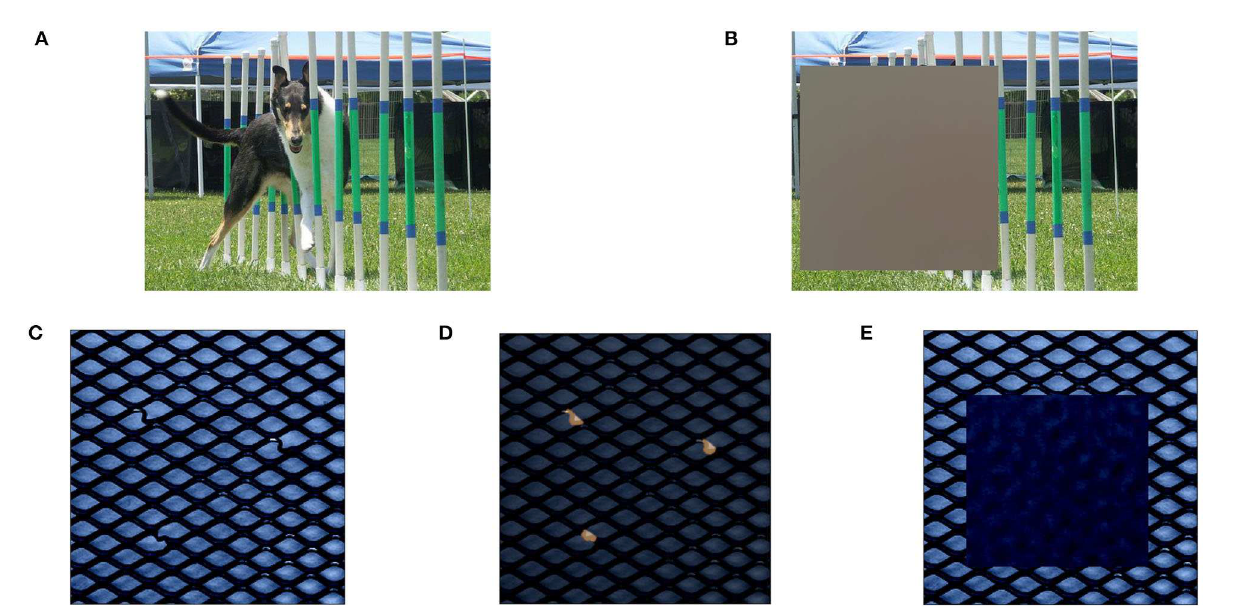
FIGURE2 Demonstration of perturbation with mean reference r in classification (A, B) and anomaly detection (C, E) . In classification, mean reference is capable of completely removing the class signal “dog” in image (B) . In anomaly detection, replacing all areas that contain anomalies [highlighted in image (D) ] with mean reference r introduces new anomalous signals in the resulting data point in image (E) .